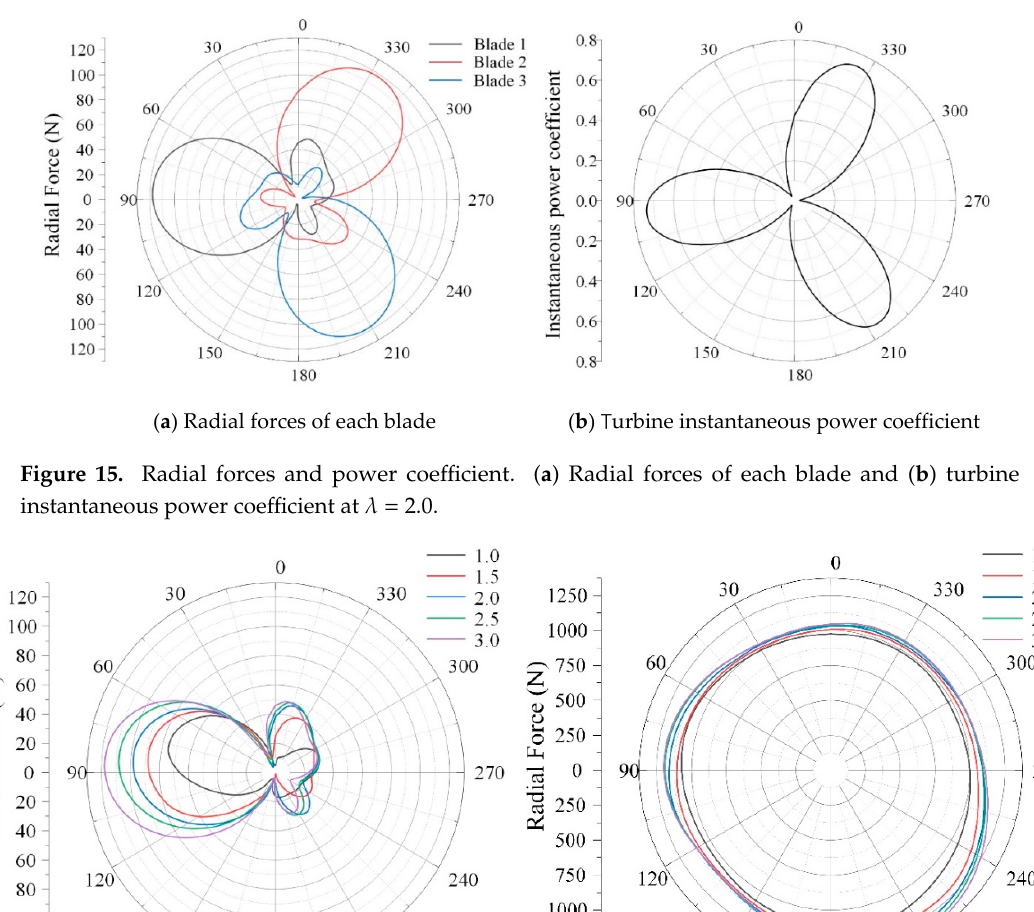
Figure 15. Radial forces and power coefficient. ( a ) Radial forces of each blade and ( b ) turbine instantaneous power coefficient at λ = 2.0.